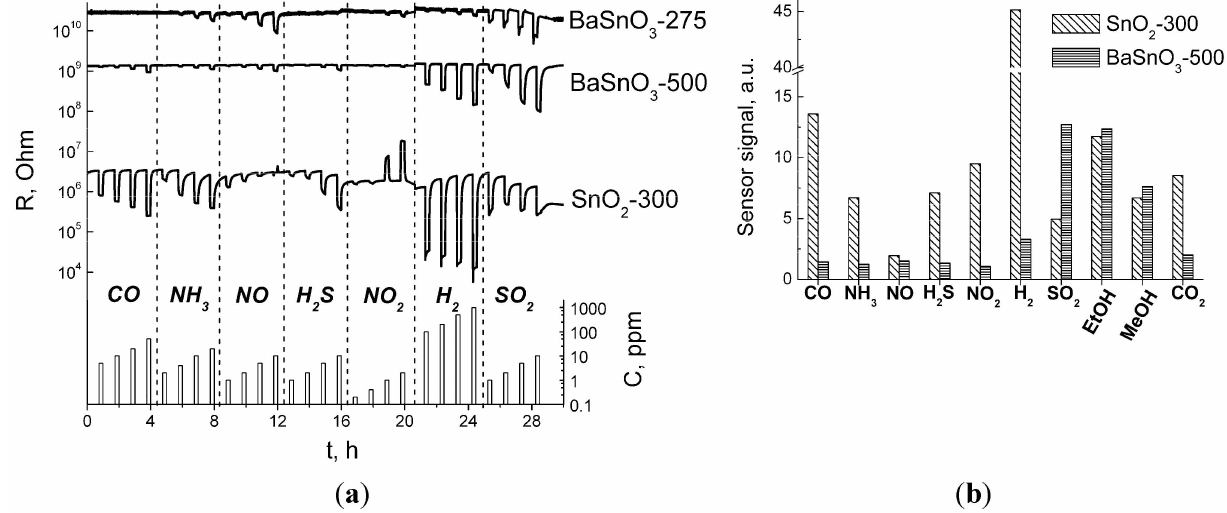
Figure 6. ( a ) Dynamic resistance plot of BaSnO to the increasing concentrations of various target gases in air measured at 300 ˝ C. ( b ) Sensor signals of BaSnO NO (10 ppm), H MeOH (20 ppm) and CO